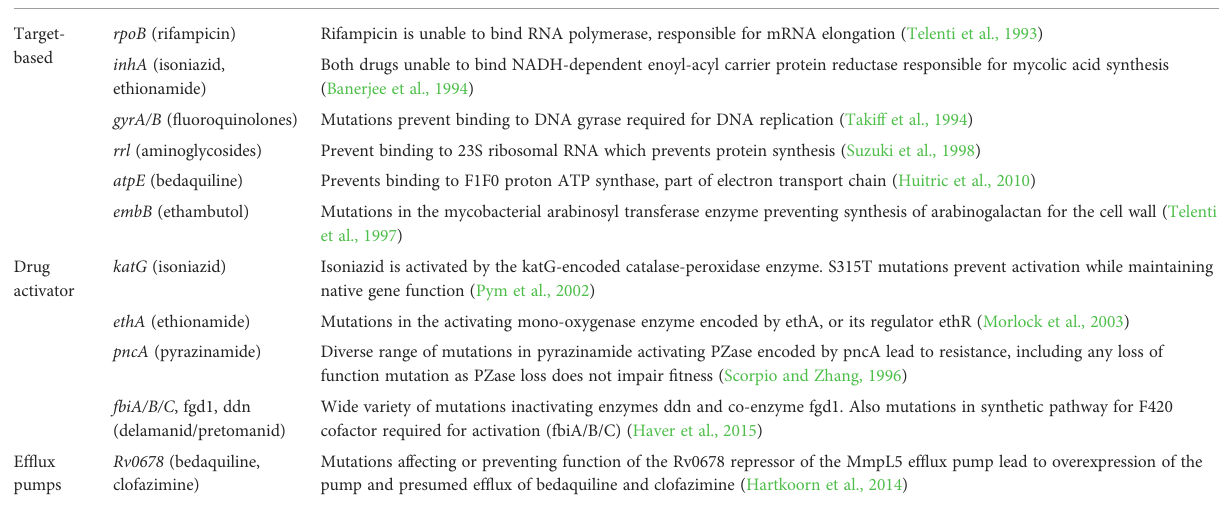
TABLE 1 Categories of mutation leading to M. tuberculosis drug